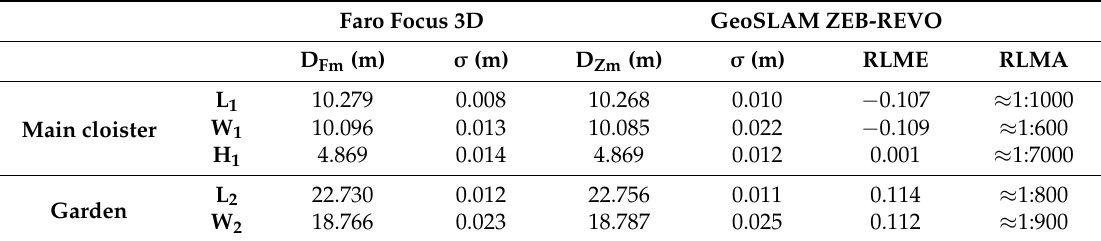
Table 4. Measured distances with standard deviations ( σ ), relative length measurement errors (RMLE) and accuracies